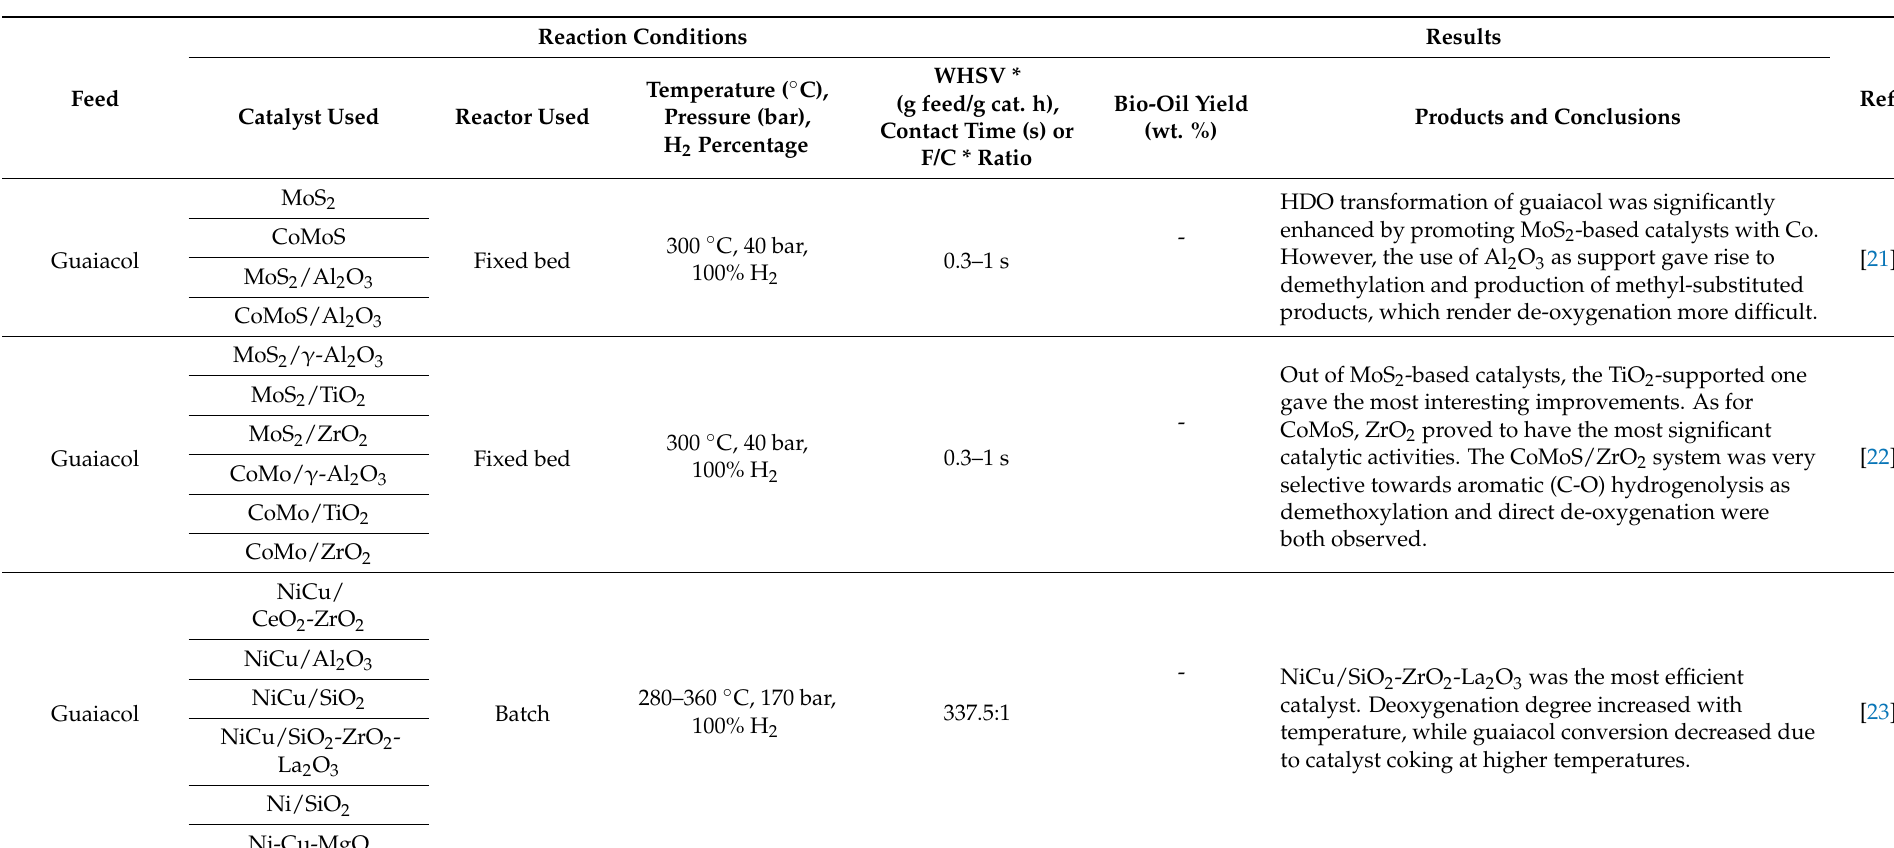
Table 2. Notable research works on catalytic